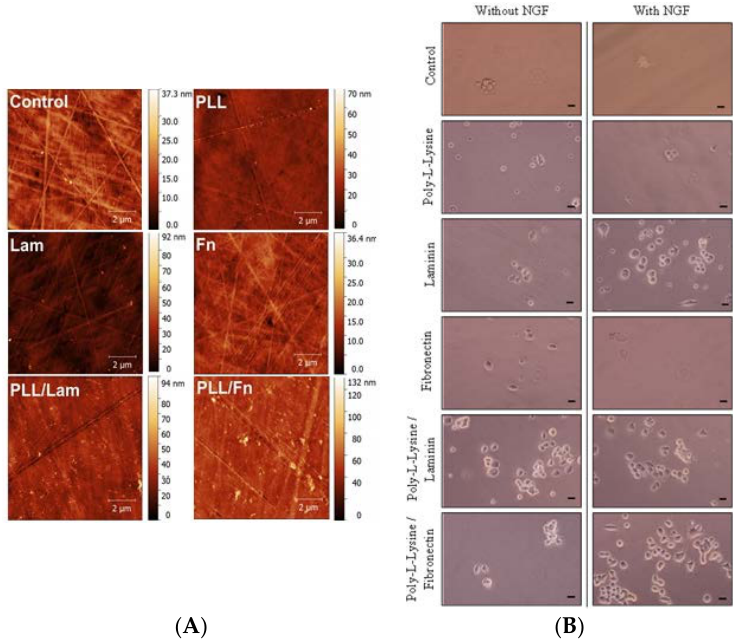
Figure 1. ( A ) AFM analysis of surfaces with different coatings. The AFM micrographs show an even distribution of single and two-component coatings on the surfaces of the polystyrene substratum. ( B ) Attachment and initial differentiation of PC12 cells after two days of incubation in the presence and absence of NGF solution. Cells were seeded at a density of 3 × 10 4 cells/mL on poly-L-lysine, laminin, fibronectin, poly-L-lysine/laminin, and poly-L-lysine/fibronectin-coated wells. The cells were grown in a medium that was supplemented with human recombinant NGF (50 ng/mL). The control wells did not contain any coating. In these experiments the PC12 cells appeared to attach to the surface in clusters. Scale bar is 5 µm.